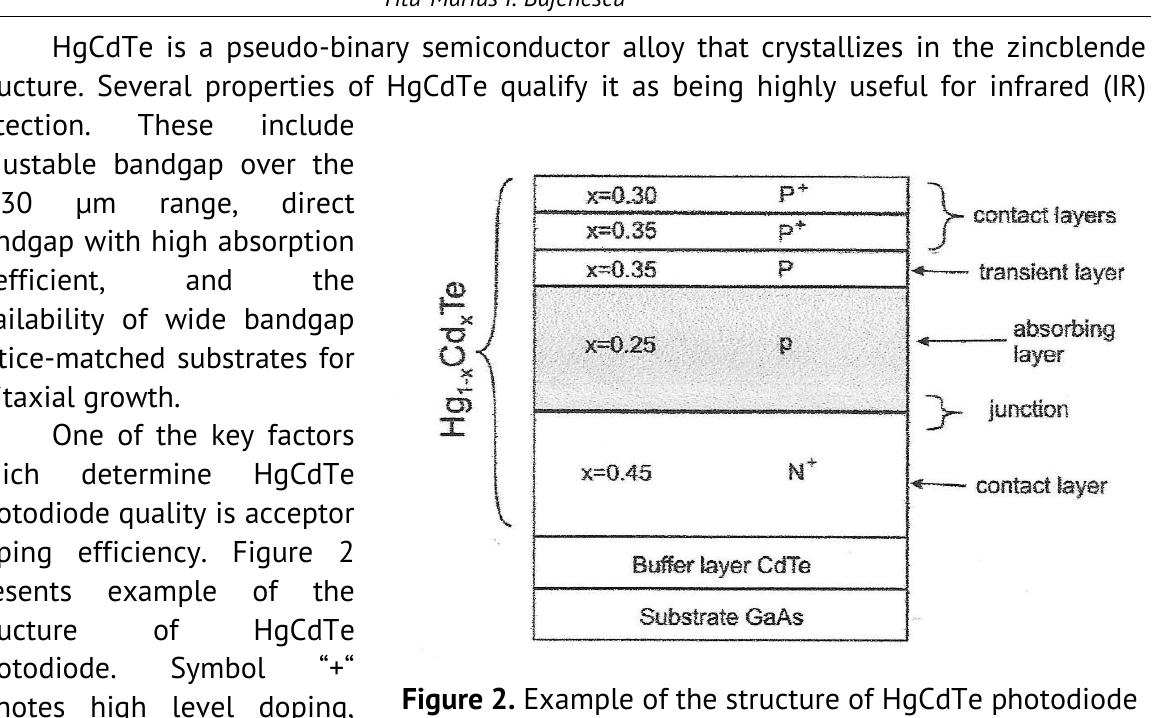
Figure 2. Example of the structure of HgCdTe photodiode (after